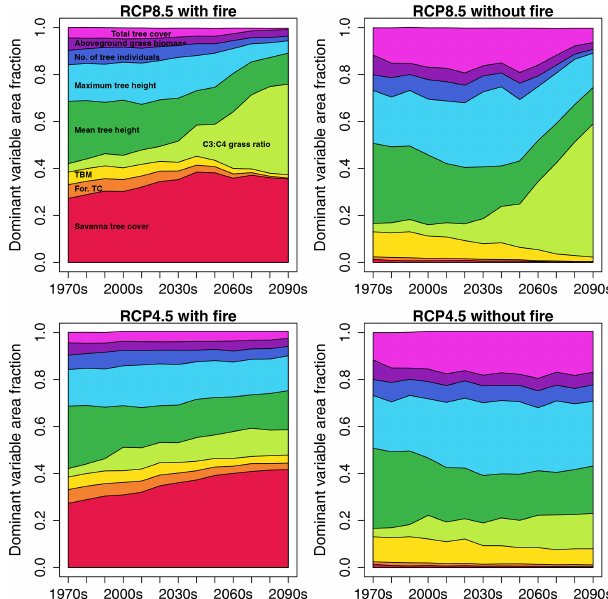
Figure 4. Fractions of African area where a given state variable is the dominant variable with respect to Euclidean distance between same-decade partners (SDPs), illustrated as time series stacks for the four scenario pairings between SDPs. Variable color coding is annotated in the panel for RCP8.5 with fire. The color coding for the variables is identical in all four